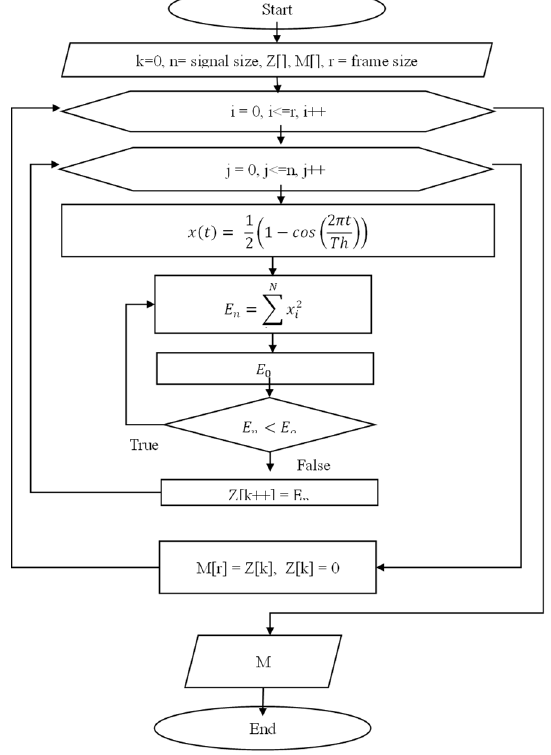
Figure 7. Hanning window algorithm for removing silent parts.